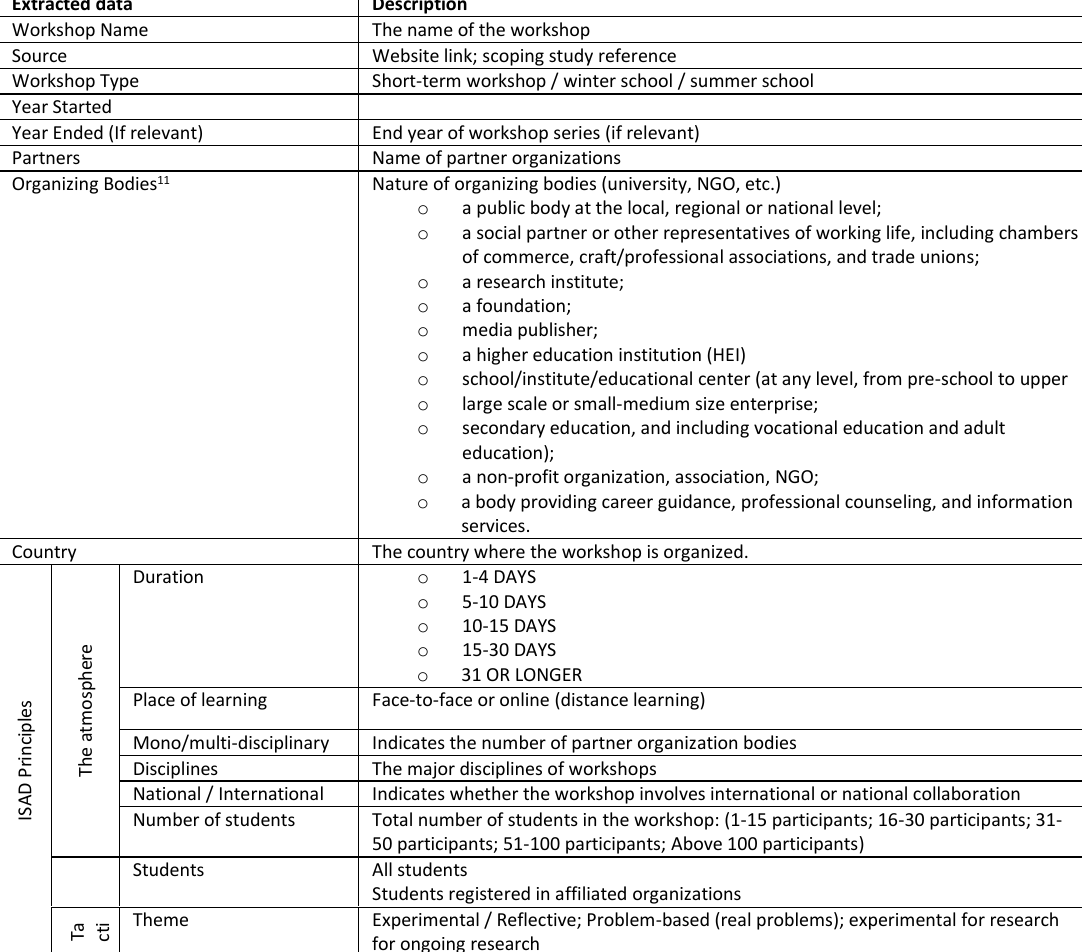
Table 6 Data extraction chart for